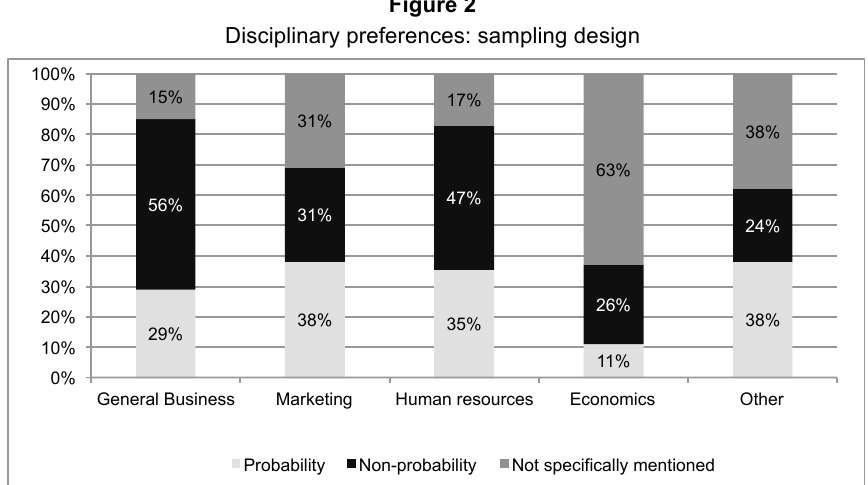
Disciplinary preferences: sampling